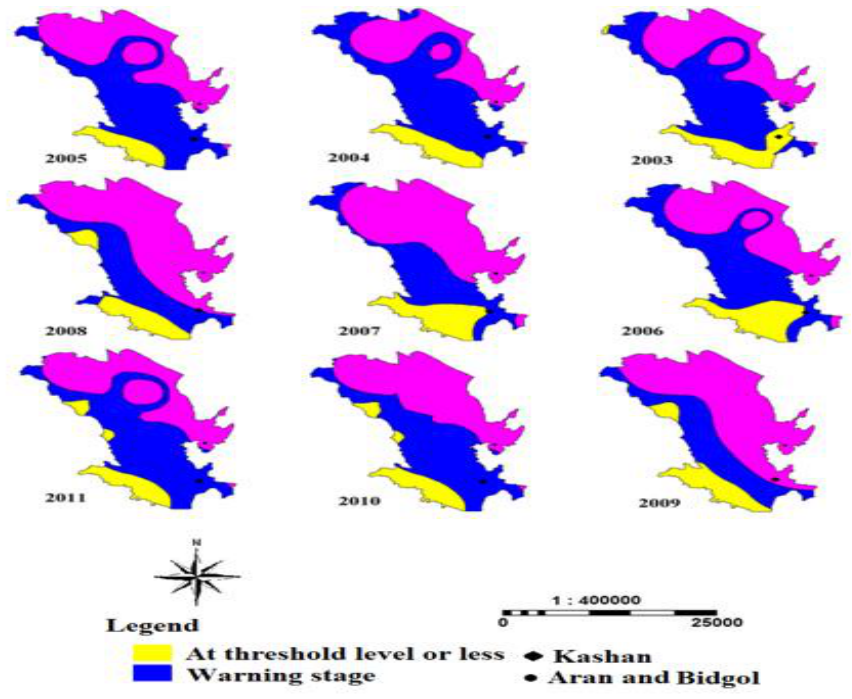
Figure 6. Map of desertification class based on EC during 2003-2011